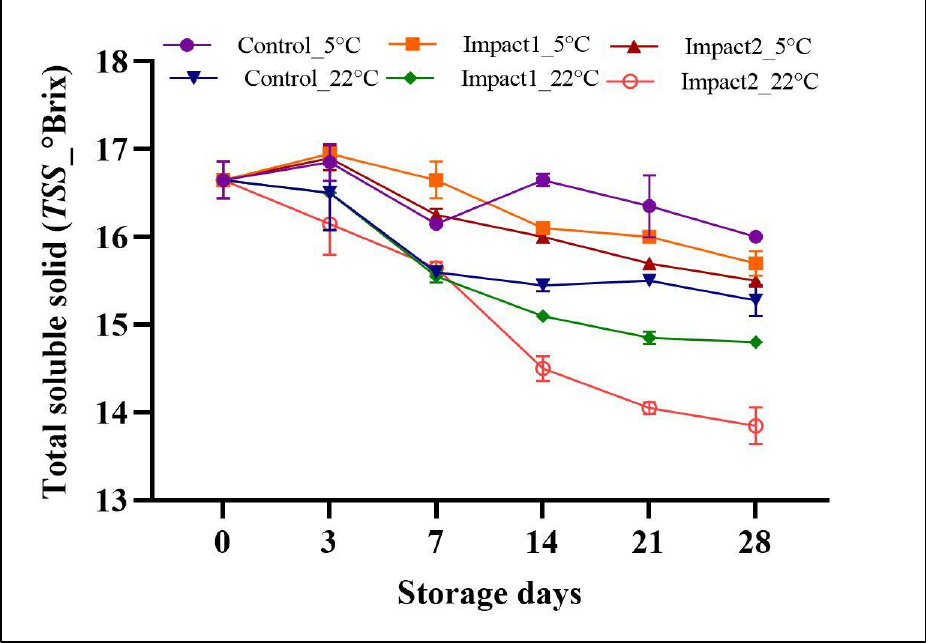
Figure 3. Total soluble solids ( TSS ) of non-bruised, low-impact (45°; 1.18 J), and high-impact (65°; 2.29 J) bruised fruit over 28 days of storage at 5 °C and 22 °C. Error bars represent the SD of the mean values of six readings per group (treatment).